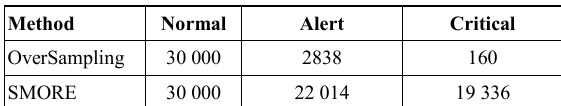
Fig. 13. SMOTE method.